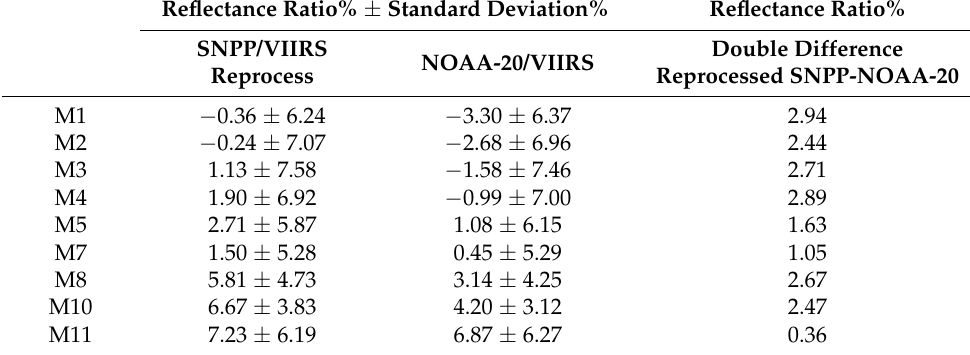
Table 6. The mean and standard deviation of the reflectance ratio percentage between reprocessed SNPP/VIIRS, NOAA-20/VIIRS, and RadCalNet at RVUS from February 2018 to August 2019, and their double difference